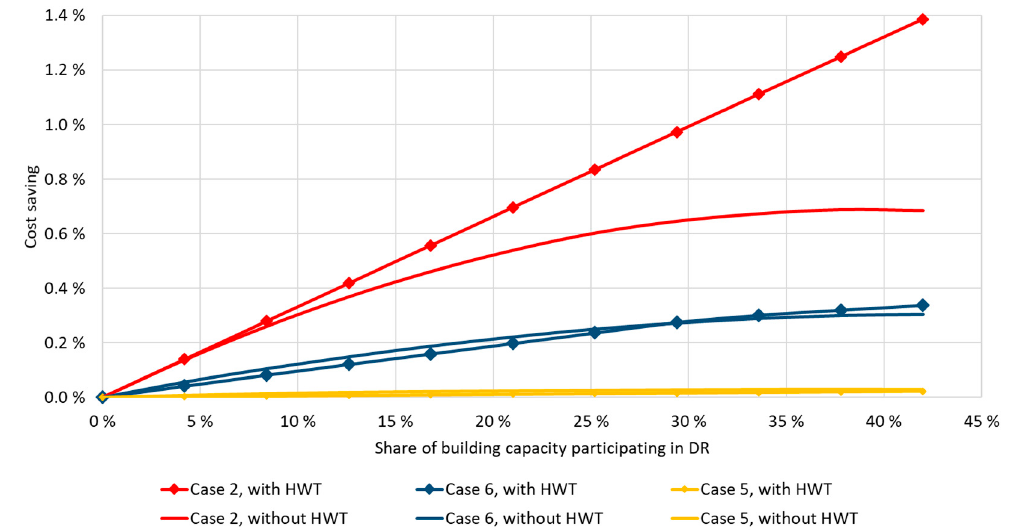
Figure 4. Cost savings in DR cases 2, 5 and 6 as a function of building capacity participating in DR.